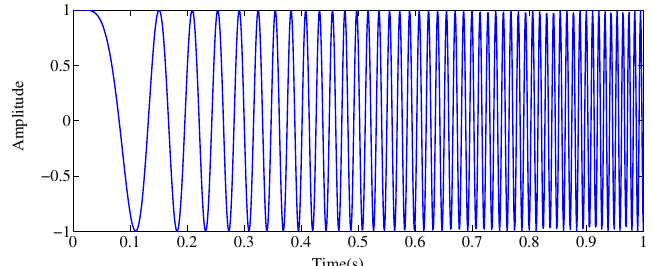
Figure 4. Chirp signal from simulation. We used MATLAB R2010a to achieve this